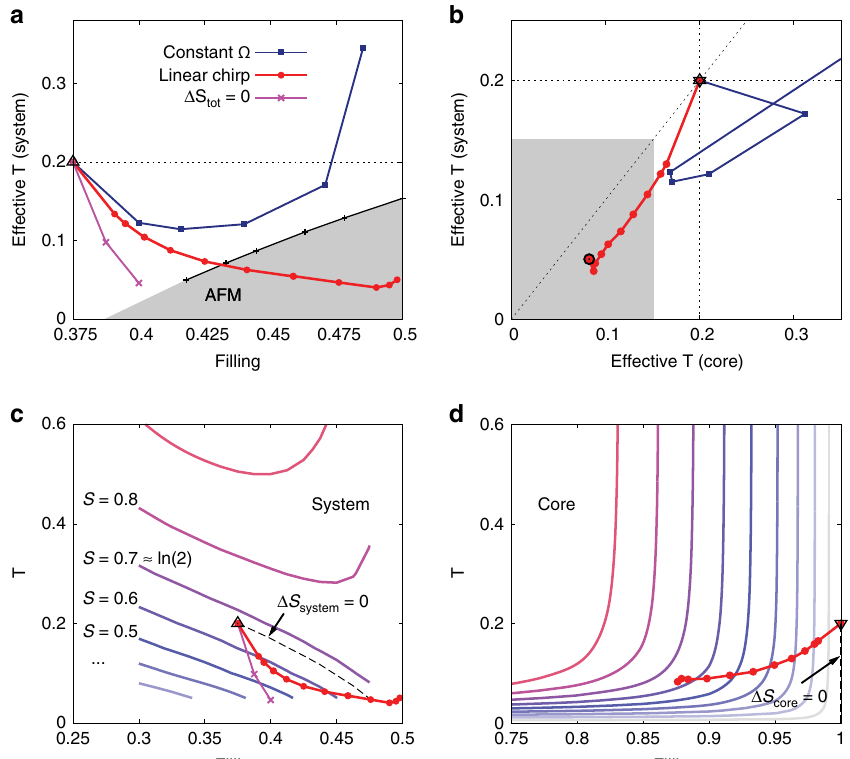
Fig. 4 Cooling in the second set-up with a single narrow core band of width 0.4. Panel a Effective system temperature as a function of fi lling. The dark blue squares indicate the lowest temperatures reachable with constant Ω ¼ 6 : 8, 7.0, 7.2, 7.4, 7.5 and optimized pulse amplitude a (from left to right), while the max ¼ 6 : 6, 6 : 7 (cid:5) Ω (cid:5) 7 : 4 and optimized a red dots are the results obtained for a chirped pulse with Ω (all data are for pulse length δ ¼ 90). Pink crosses in fin max show the temperatures achievable with an insentropic charge transfer. Symmetry breaking to an antiferromagnetic state is expeced in the gray region. Panel b Effective system temperature against the effective core temperature for the same driving protocols as in panel a . With chirped pulses, both the system and core electrons are cooled below the initial temperature of 0.2. The gray shading indicates the Néel temperature of the system for the fi lling realized with the highest frequency pulse (black circle). Panel c The isentropy curves of the system in the space of fi lling and temperature, together with the data for the chirped pulse and the isentropic charge transfer. Both protocols lead to a decrase of the system entropy S over a large doping range. Panel d plots the isentropy system curves of the core and the fi lling-versus-temperature data corresponding to the chirped pulse. The hole doping of the core band leads to a strong increase in the entropy S . The up (down) triangles in panels a – d represent the initial state of the system (core), before the core